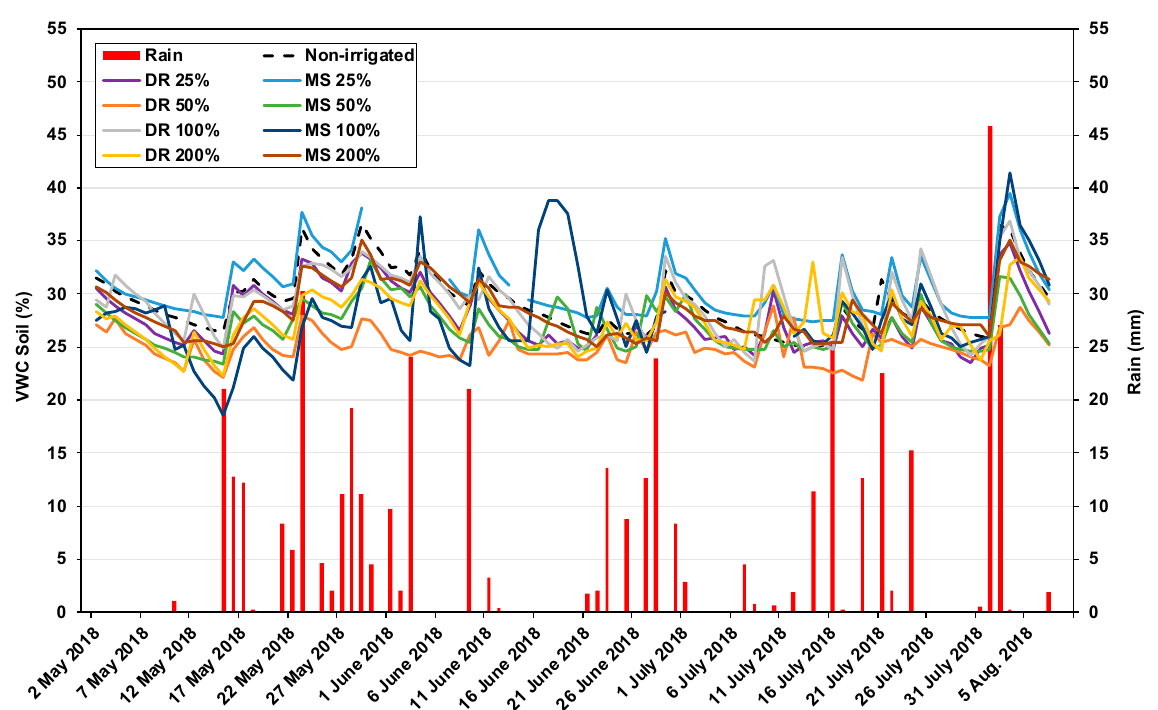
Figure 3. Soil volumetric water content (VWC) for the non-irrigated treatments and for the different combinations of drip